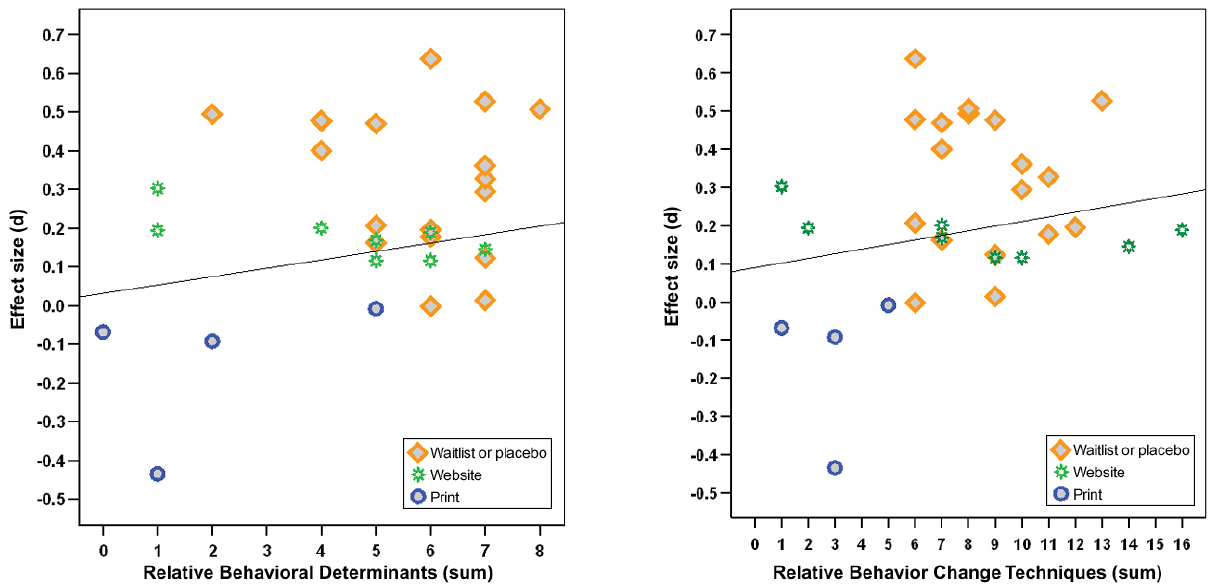
Figure 5. Sum of influence components by effect